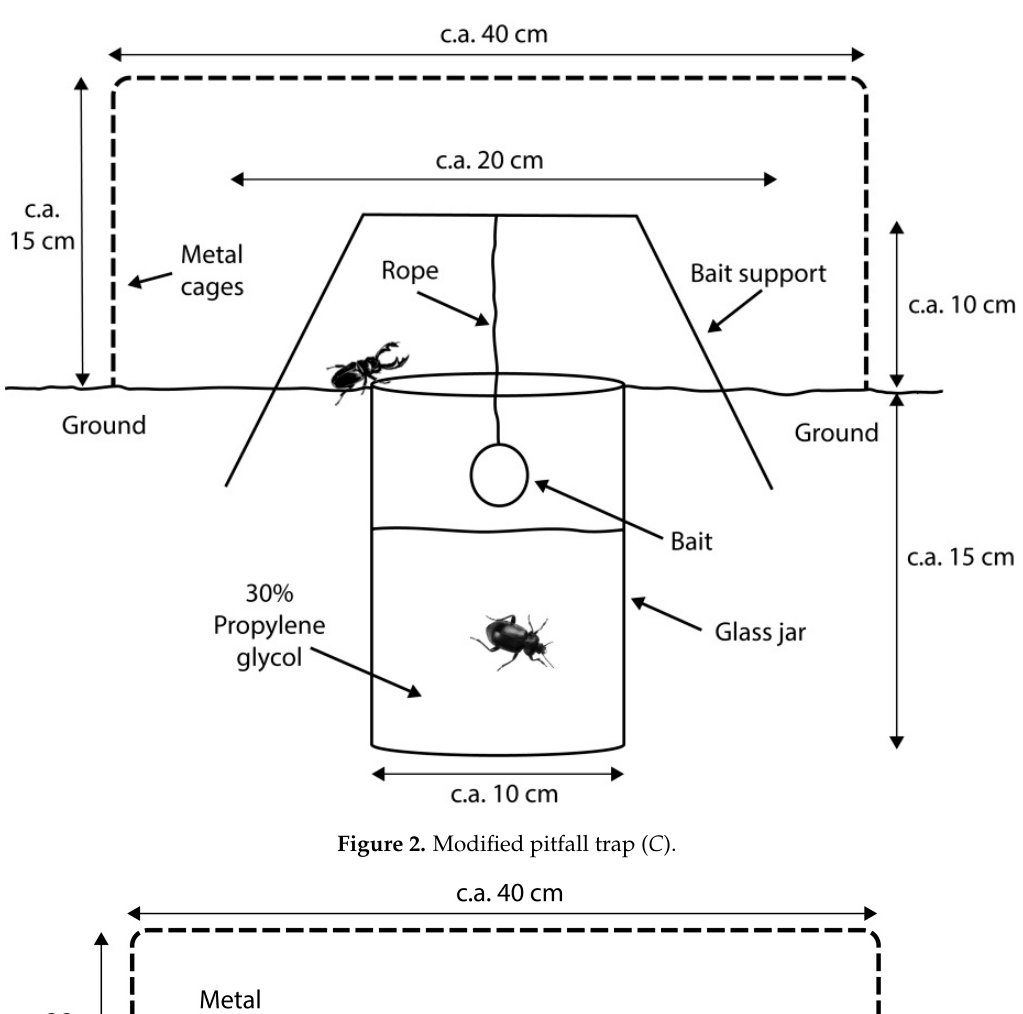
Figure 2. Modified pitfall trap ( C ).